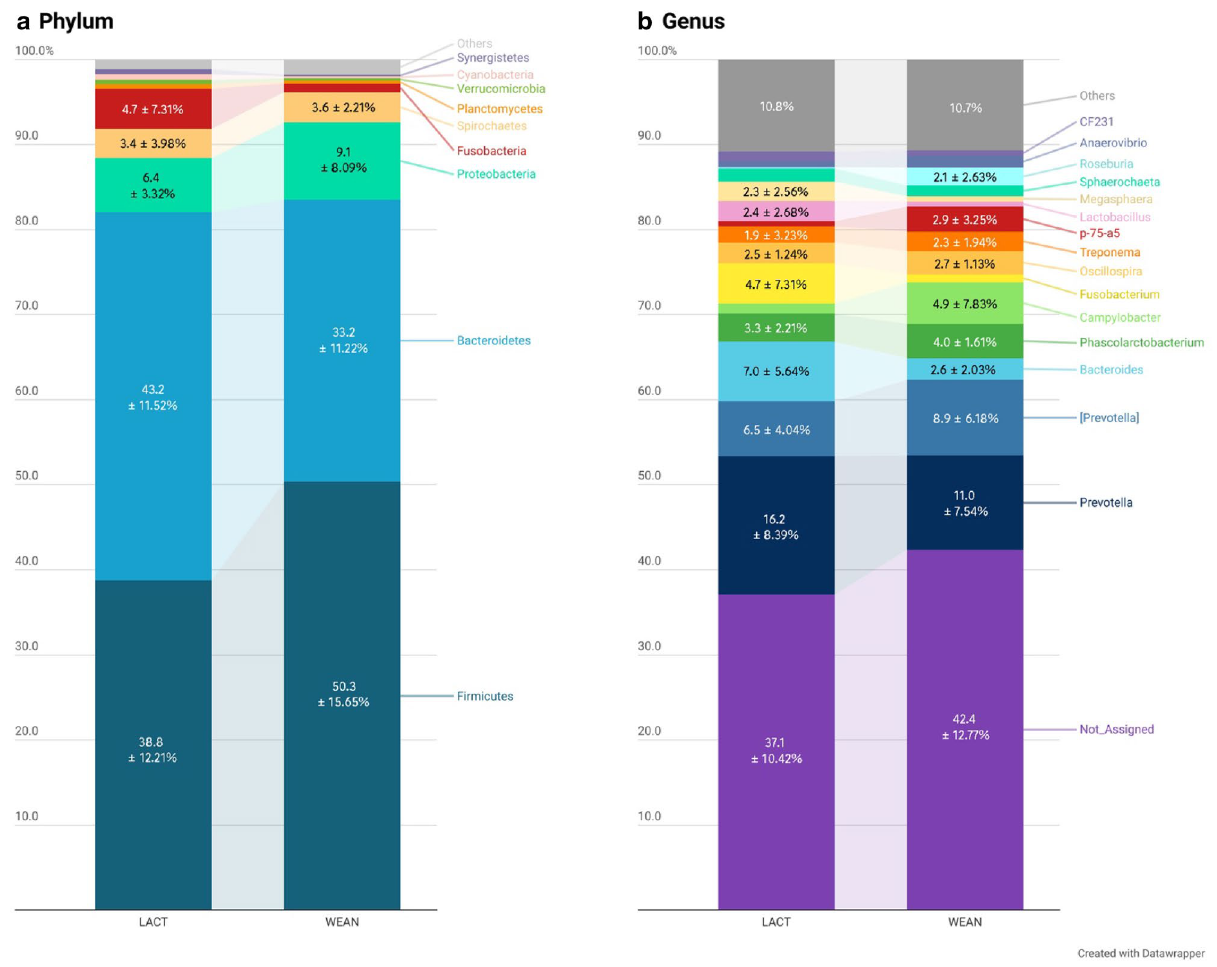
Figure 2. Bar plot of the relative abundances (RA) expressed in percentage of the phyla ( a ) and main genera ( b ) observed in the analysis of the microbiota of piglets by massive sequencing of the 16S rRNA gene. Bar plot LACT represents the relative abundances observed during lactation, while bar plot WEAN represents the values observed in weaned piglets. Only taxa with RA greater than 2.0% were annotated with RA percentage ± SD. Figure created with the online open-source tool Datawrapper (http:// dataw rapper.